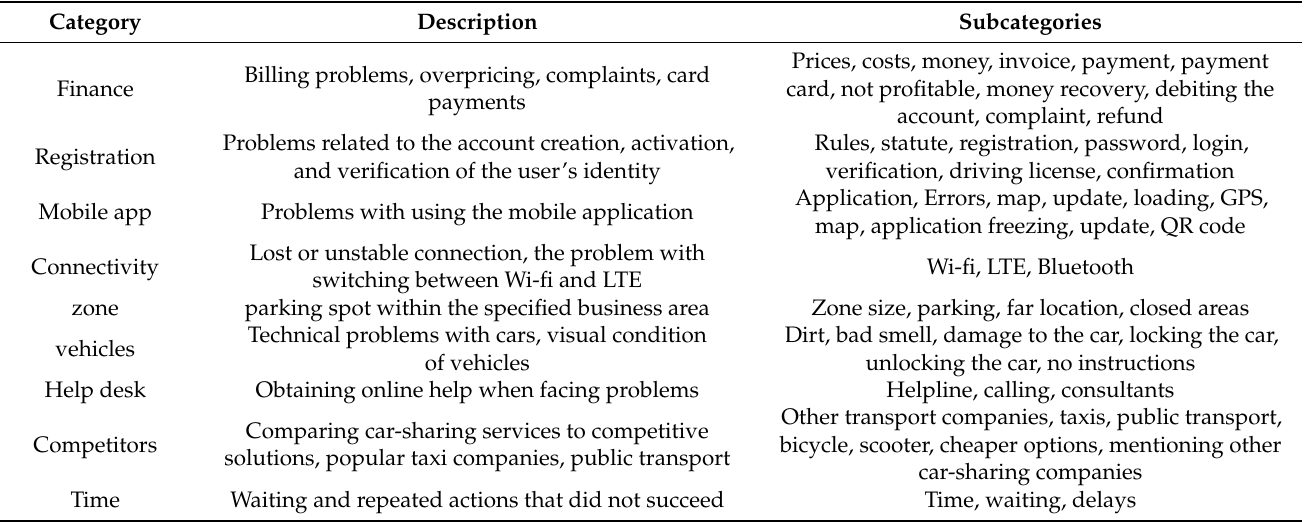
Table 4. Categories and subcategories of topics used for tagging the users’ comments.